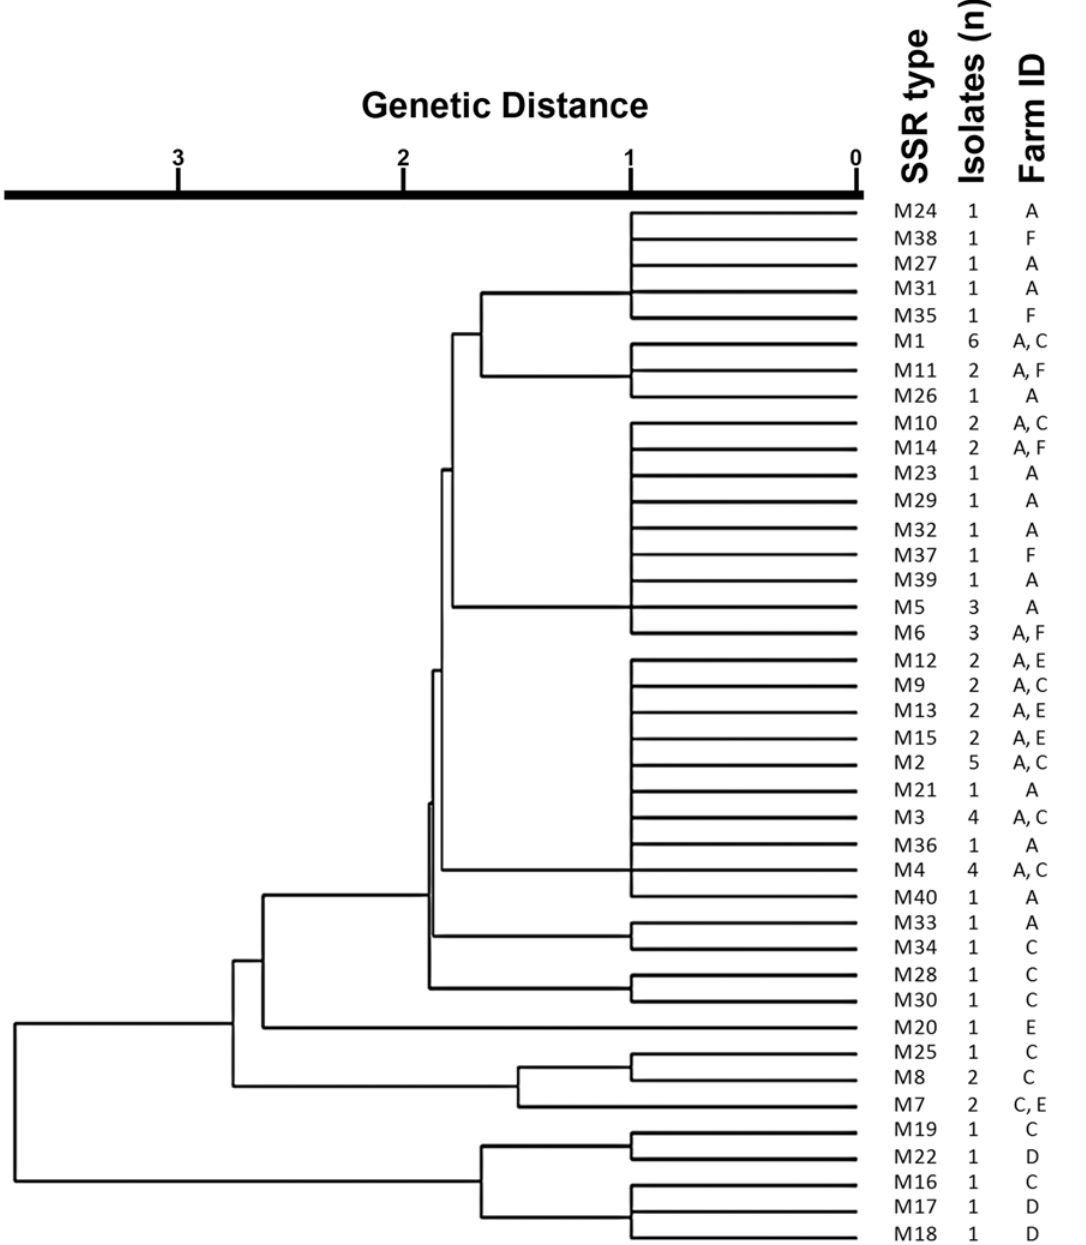
Fig 1. Dendrogram representing the genetic relationship between all Map isolates based on the 4 SSRs loci used in the analysis. The dendrogram was built using the unweighted pair group method with arithmetic mean (UPGMA) using the BioNumerics 7.1 multilocus sequence typing program. Genetic distance is indicated at the top of the dendrogram. SSR-types, number of Map isolates (n) and farm ID are displayed to the right side of the